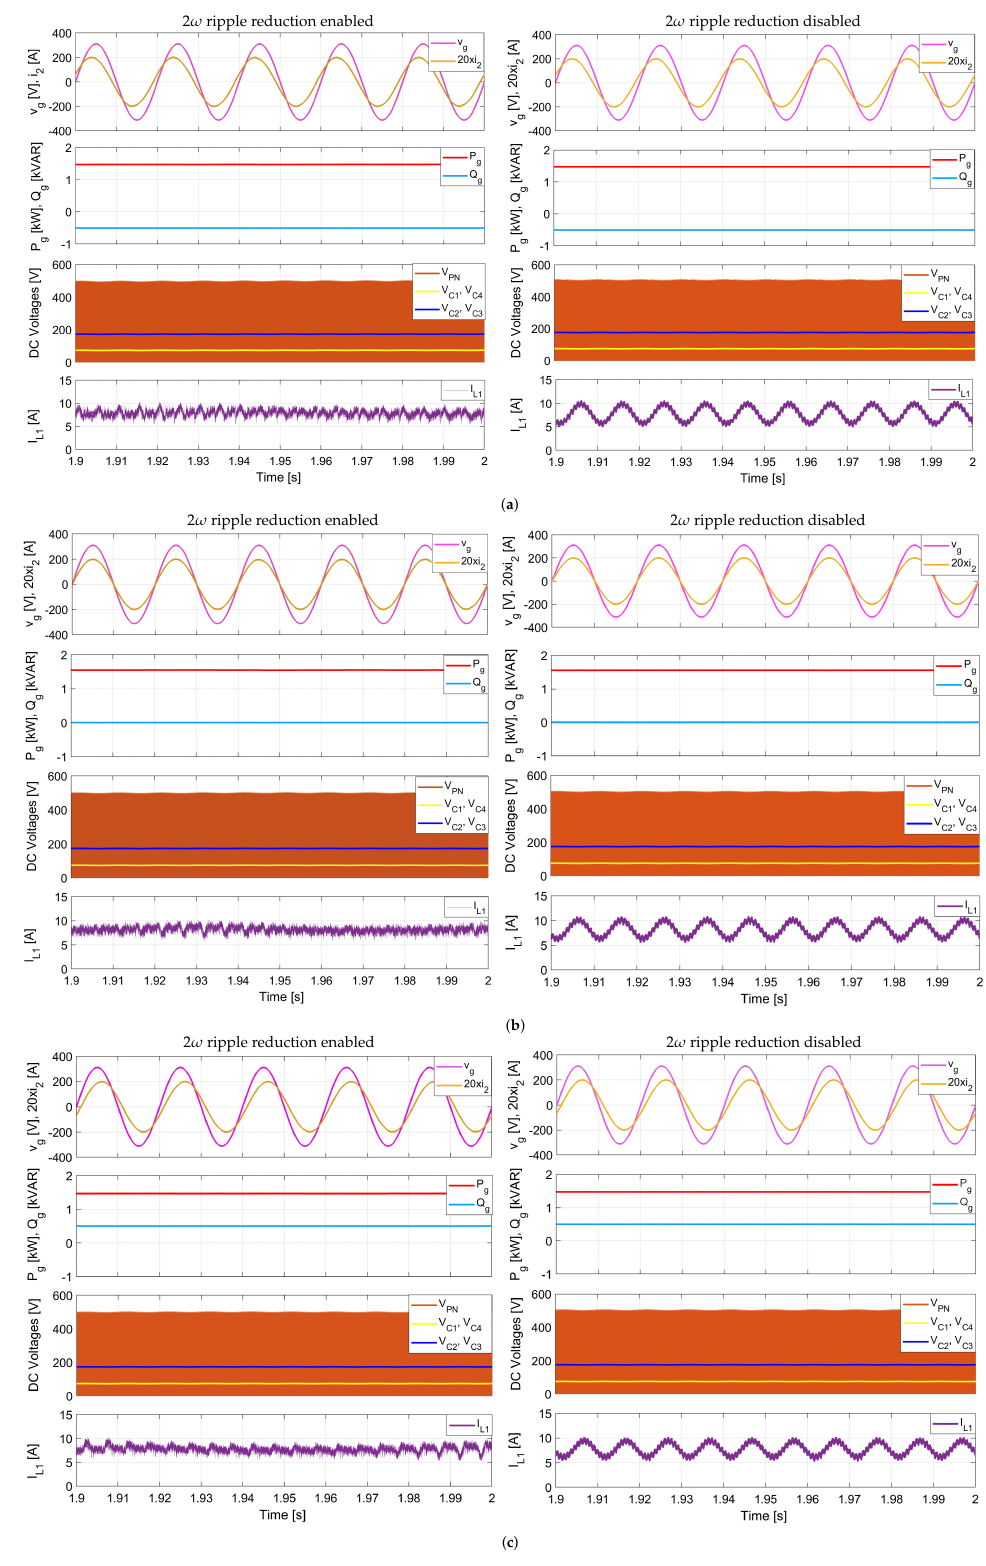
Figure 10. Simulation results of different power factors with and without the 2 ω reduction technique; ( a ) P g = 1.5 kW, Q g = 0.5 kVAR; ( b ) P g = 1.5 kW, Q g = 0 kVAR; ( c ) P g = 1.5 kW, Q g = +0.5 kVAR. −